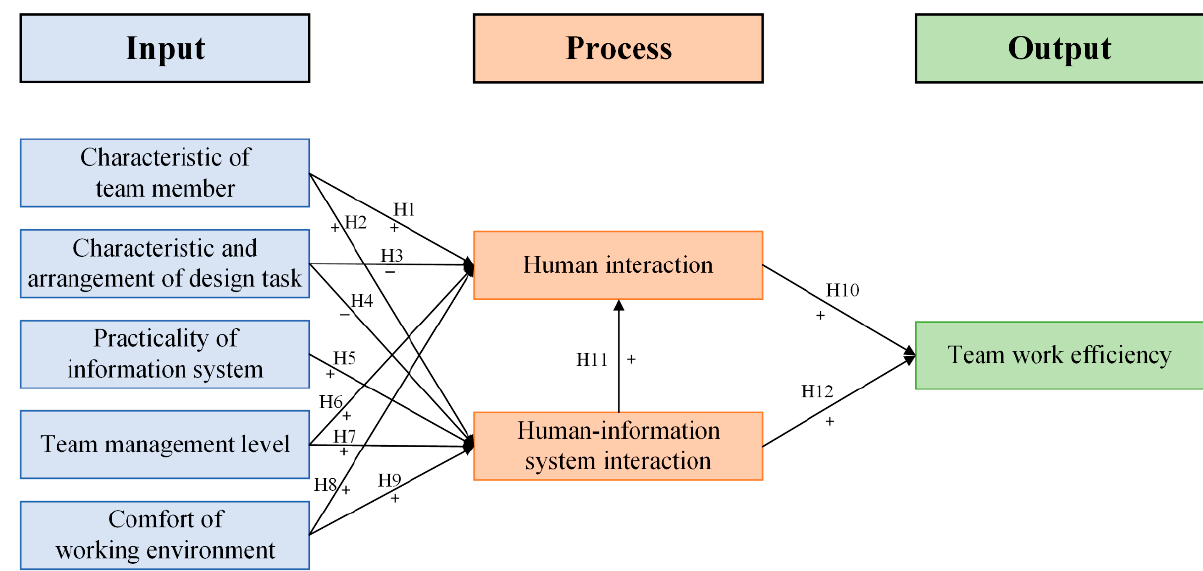
Figure 1. The preliminary hypothetical model. Note: “+/ − ” indicates a positive/negative impact.